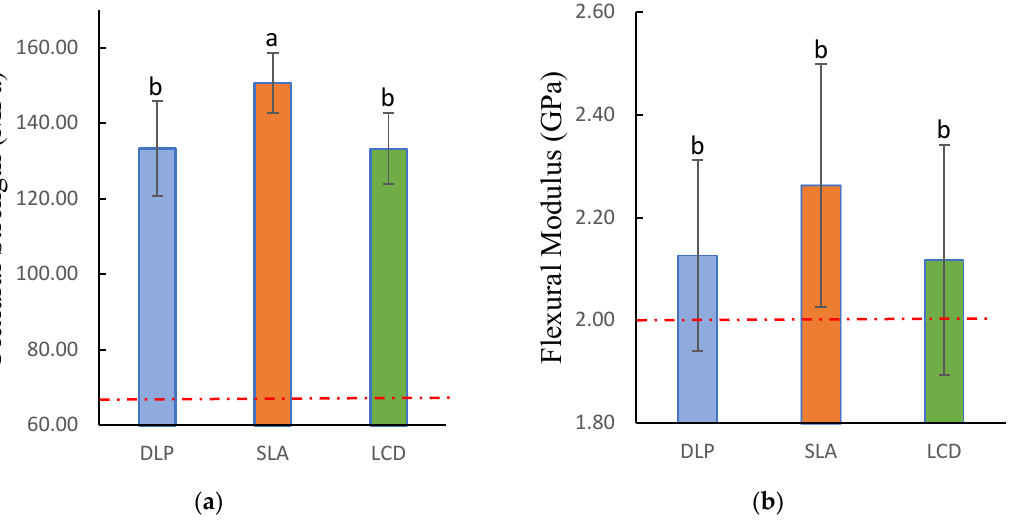
Figure 6. Flexural strength and modulus of 3D-printed denture base resin specimens: ( a ) flexural strength; ( b ) flexural modulus. Similar letters indicate insignificant differences. Red dotted lines indicated the minimum requirements according to ISO